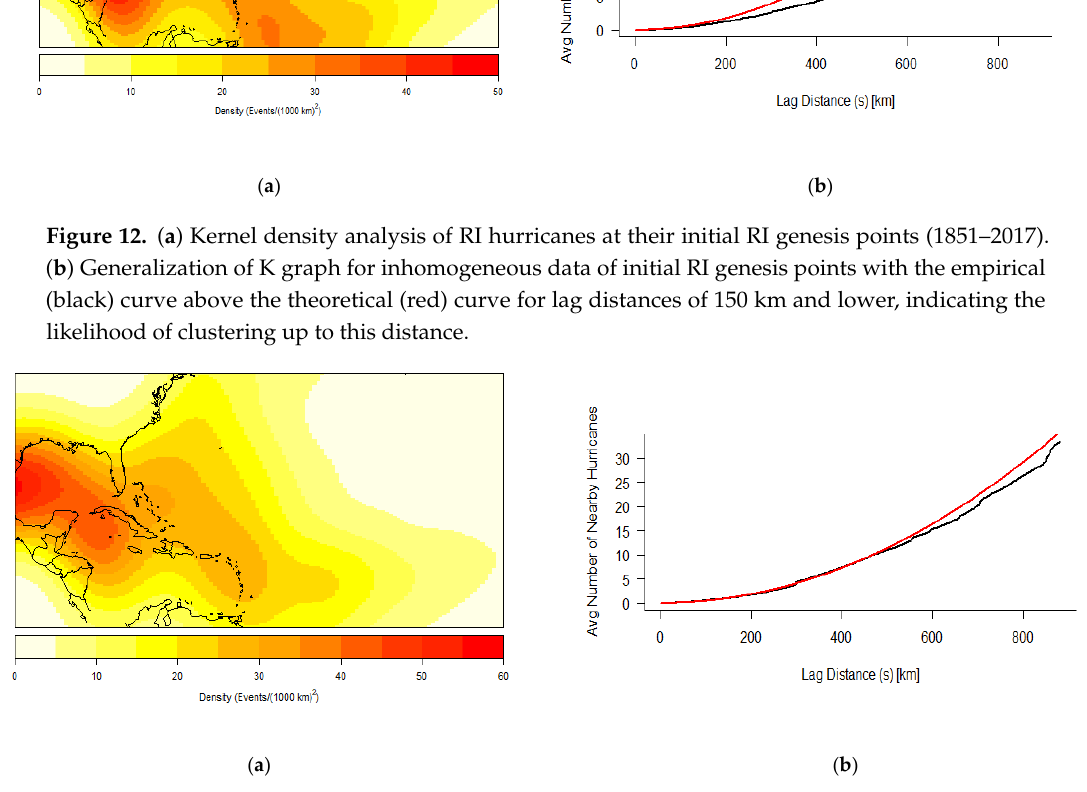
Figure 13. ( a ) Kernel density analysis of RI hurricanes at their initial RI completion points (1851–2017). ( b ) Generalization of K graph for inhomogeneous data of initial RI completion points with the empirical (black) curve above the theoretical (red) curve for lag distances 500 km and lower, indicating the likelihood of clustering for all distances up to this point. Storms that were determined to have made landfall were plotted using a kernel density analysis. Figure 14a indicates clustering throughout the Gulf of Mexico coastlines. A generalization of K test for landfall points (Figure 14b) shows a higher empirical curve up to a lag distance of 750 km and then a higher theoretical curve for the remaining lag distance. This suggests a likelihood of clustering for storms up to 750-km apart but CSR for any storms beyond that lag distance.